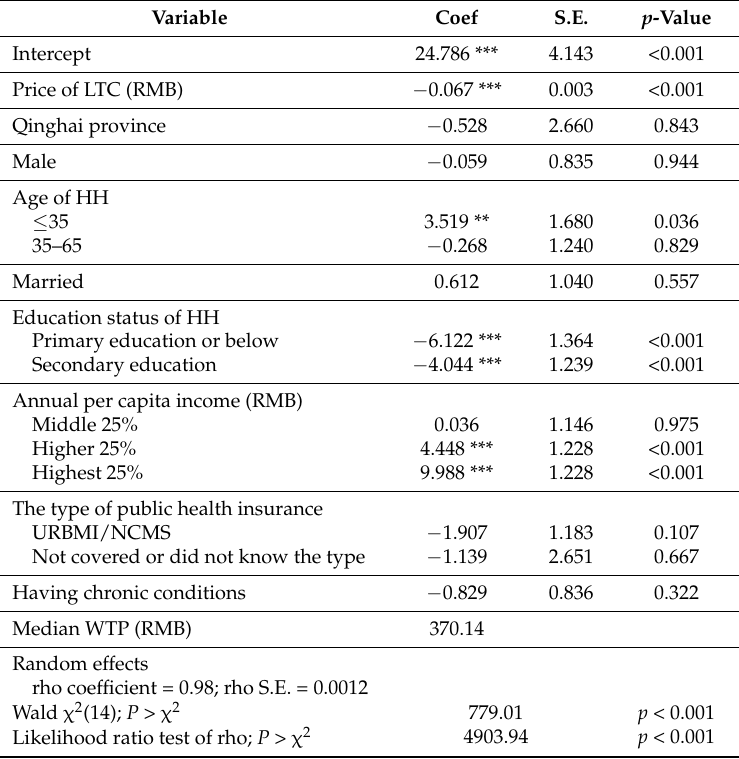
Figure 1. Acceptance rate (%) and bids (RMB). Table 3. Coefficients of random effects logistic regression ( N = 13,944).